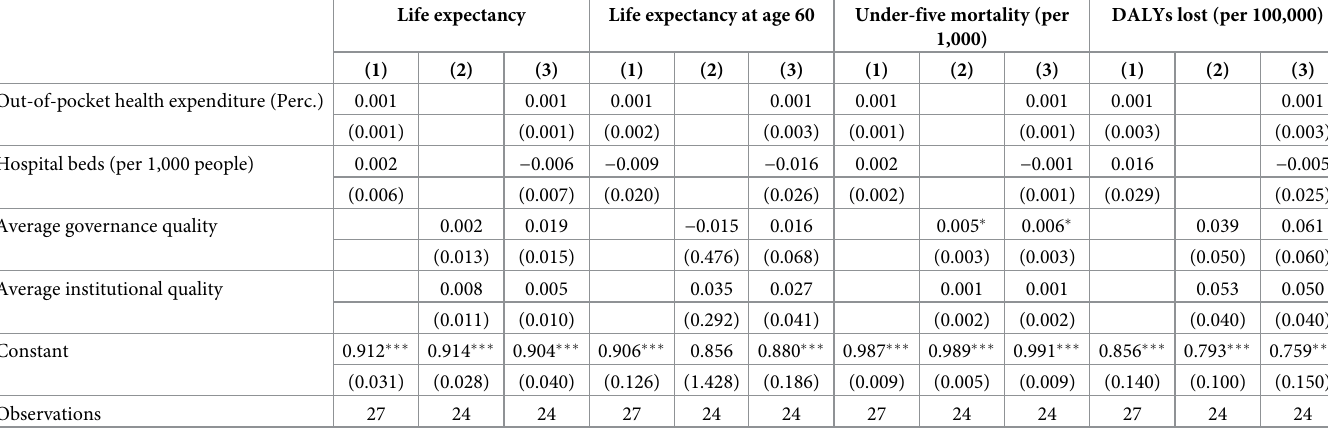
Table 2. Regression results of potential efficiency determinants: Health outcomes.